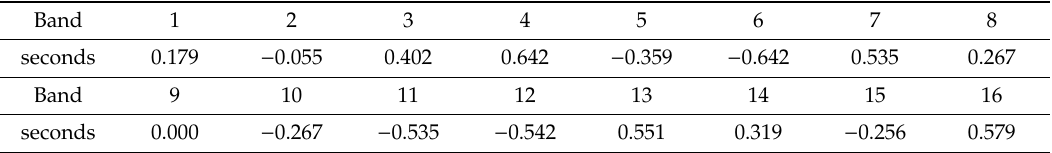
Table A1. Time o ff sets of the ABI spectral bands relative to the optical